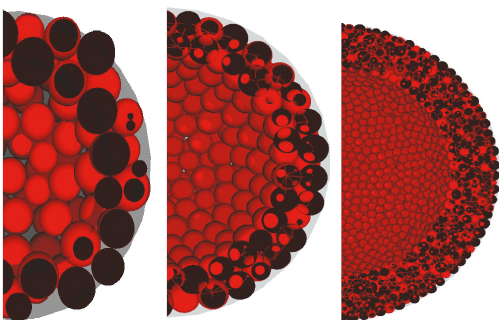
Figure 19: Hollow spheres with 1 , 2 , and 4.2 elements in the thickness and, respectively, 632, 2300, and 10676 elements in